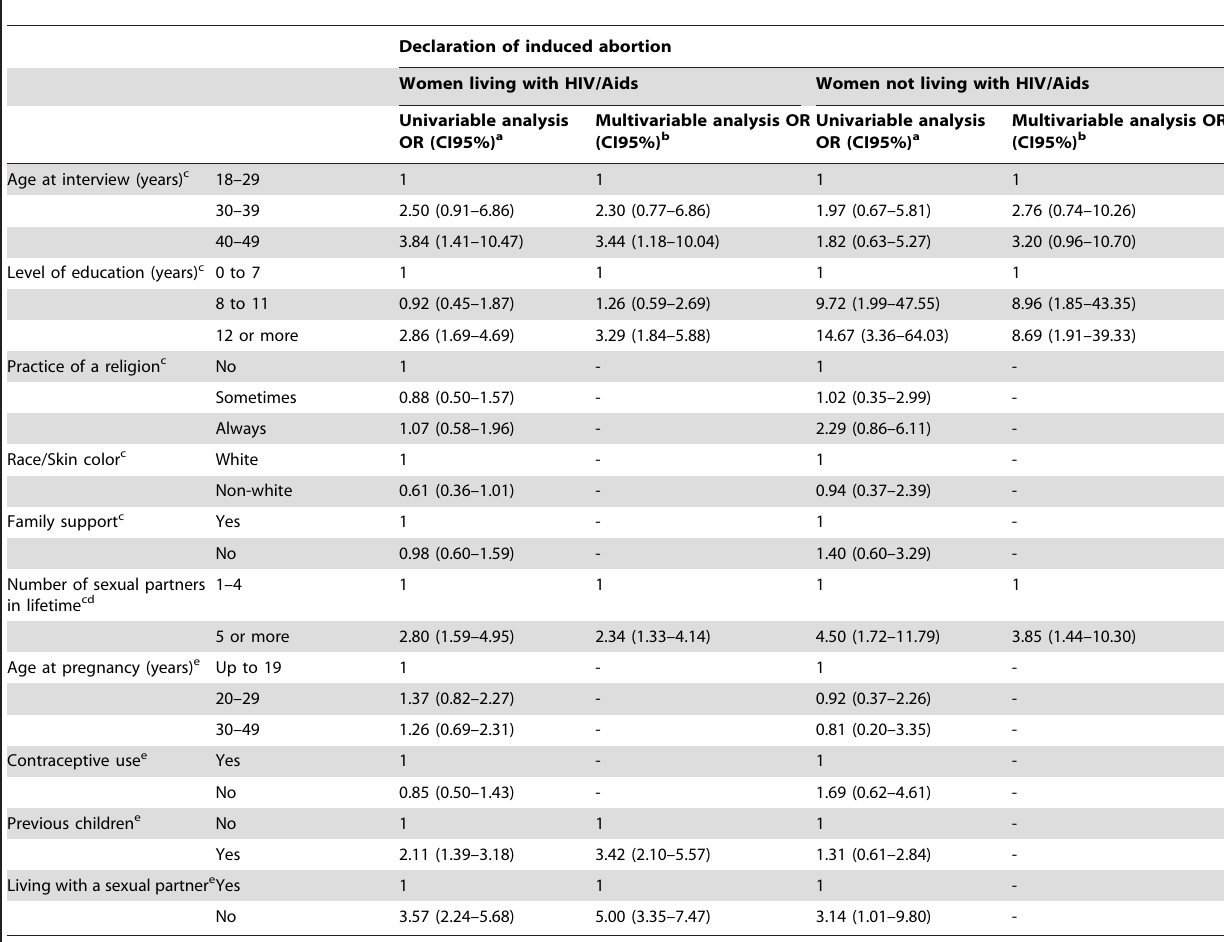
Table 5. Odds ratio and 95% confidence interval for declaration of induced abortion among women living with HIV/Aids and women not living with HIV/Aids, estimated through the univariable and multivariable GEE logistic